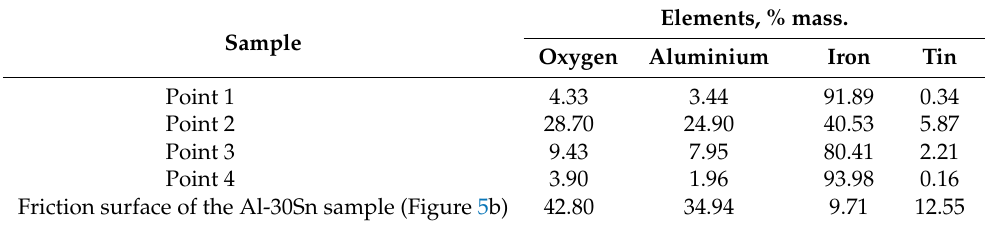
Table 2. Elemental composition (EDX) of the friction track on the steel counterbody shown in Figure 6a.